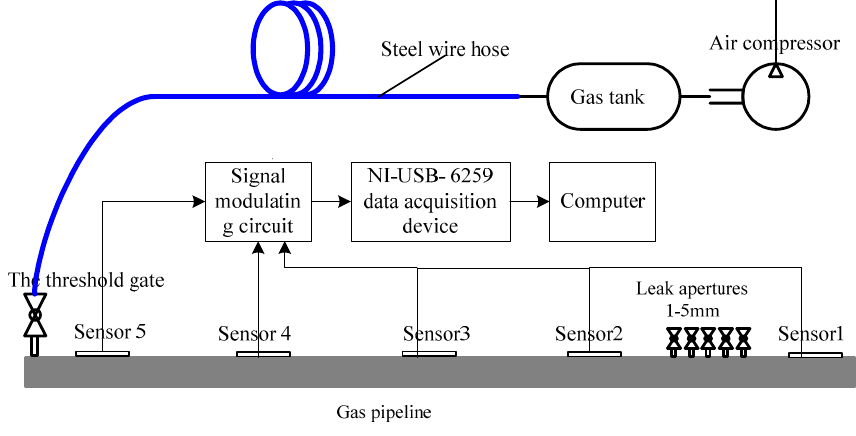
Figure 5. Experiment system schematic.